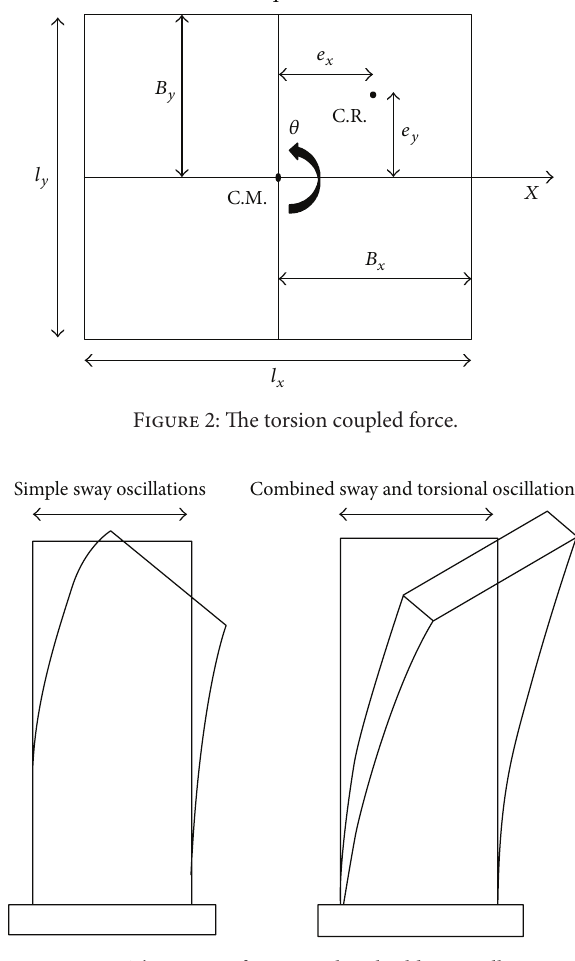
Figure 3: The seismic forces result in building